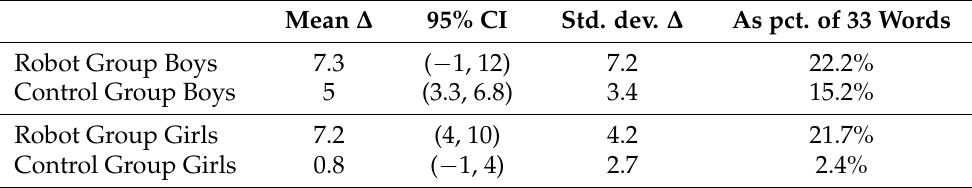
Table 5. Breakdown of vocabulary scores for genders by group; the 95% confidence interval was calculated by bootstrapping. Mean ∆ 95% CI Std. dev.